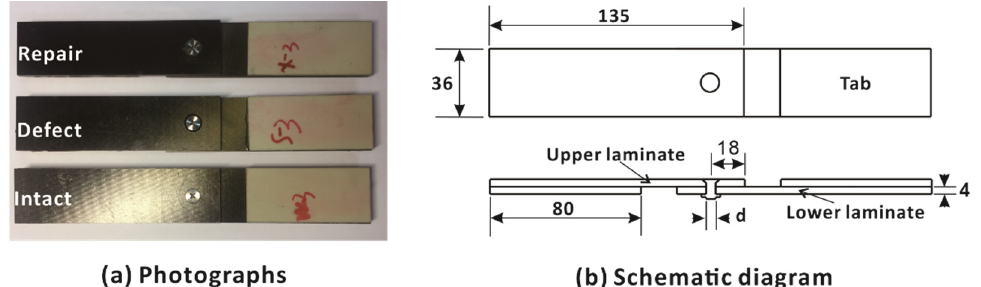
Figure 1. Photographs and schematic diagram of the tensile test specimen (all dimensions in mm).